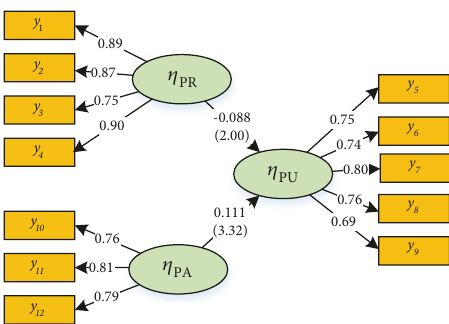
Figure 7: MIMIC submodel for